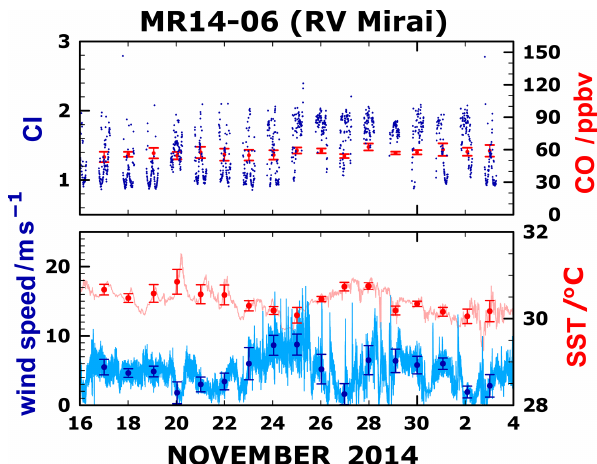
Figure 6. Time series of the CO mixing ratio (ppbv), color index (CI; defined as the ratio of the measured intensities at the two wave- lengths of 500 and 380nm; Takashima et al., 2009), wind speed (ms − 1 ), and SST ( ◦